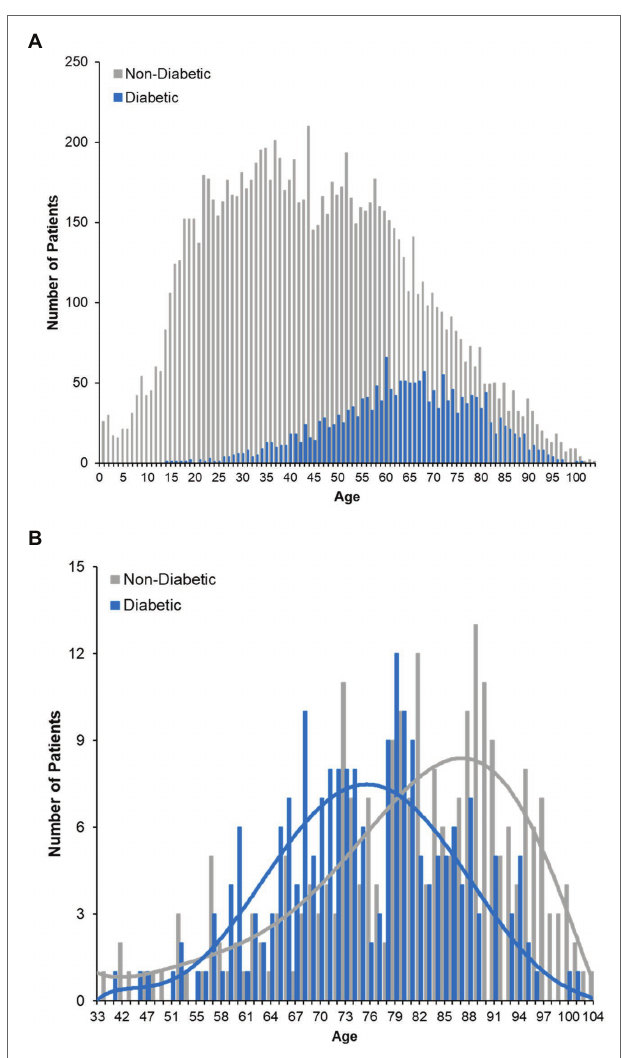
FIGURE 4 | COVID-19 fatality and diabetes. (A) Histogram plot of the ages of diabetic COVID-19 patients in dataset. Survivors are plotted with red bars and those that died with green bars. (B) Age distribution of deceased patients bifurcating non-diabetic and diabetic patients.